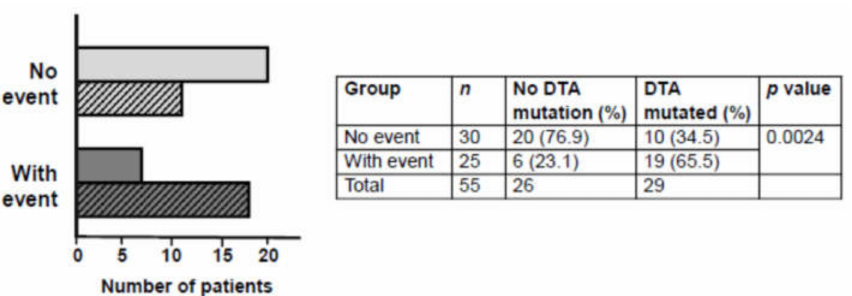
Figure 2. Frequency of DTA mutations in the no thrombotic event and with thrombotic event groups of PV patients. A significant association was observed between event and the presence of DTA mutation. Open bars represent no DTA mutation, hatched bars represent a DTA mutation. DTA: DNMT3A, TET2, ASXL1 . Odds ratio 4.68 (95% confidence interval